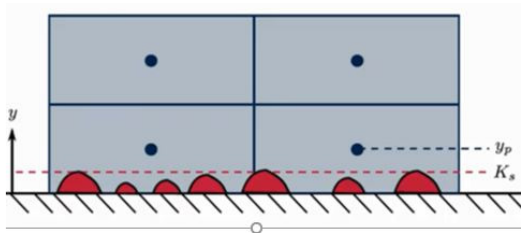
Figure 4. Schematic diagram for roughness height.